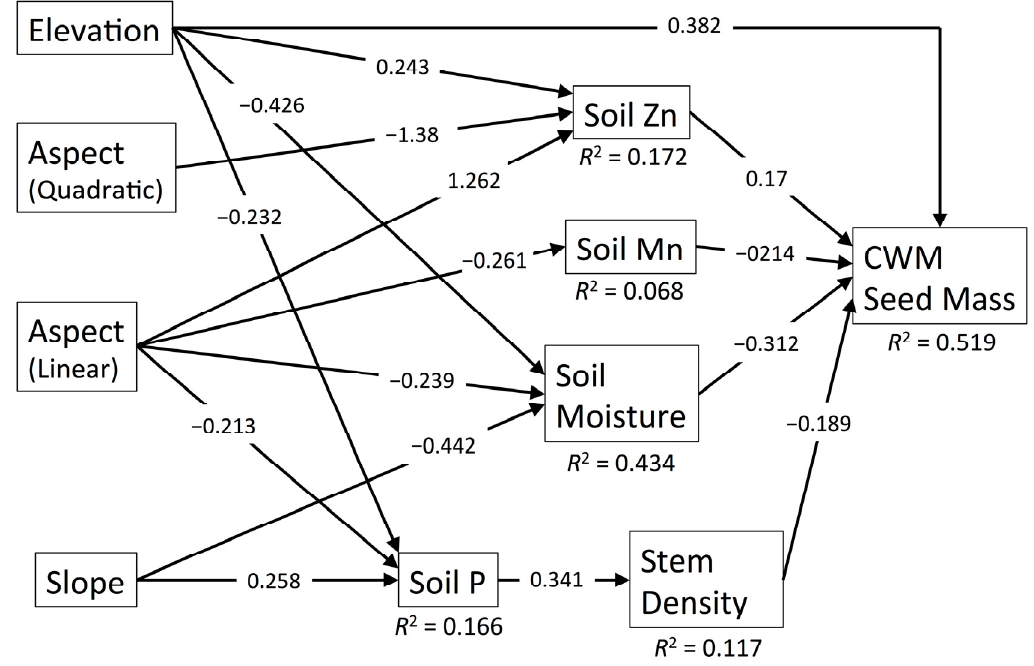
Figure 7. Path diagram for community-weighted mean seed mass. Standardized path coefficients are given. R 2 values are total explained variance.